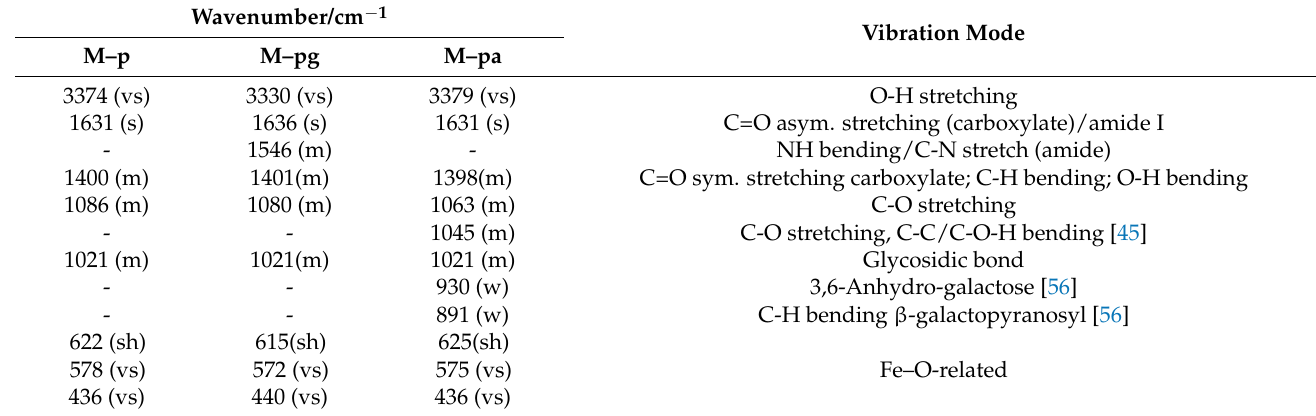
Table 3. Main bands and corresponding vibration modes in the FTIR of magnetic nanoparticles synthesized in the presence of Pectigel food additive, either alone or in mixed media with food ‐ grade gelatin or agar. vs = very strong; s = strong; m = medium intensity; w = weak; sh = shoulder.